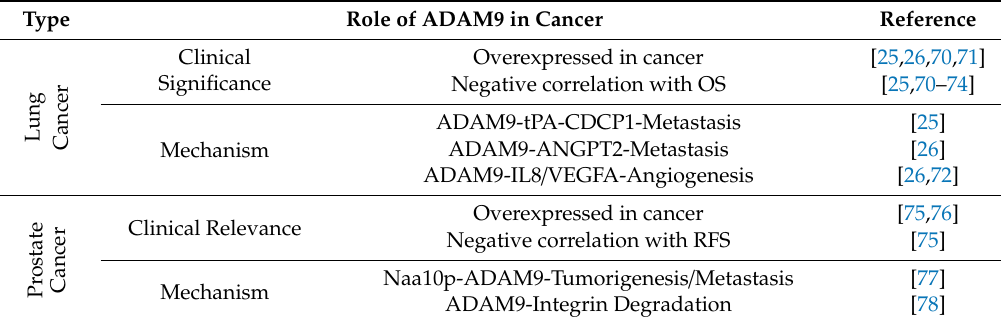
Table 1. Studies of ADAM9 in various